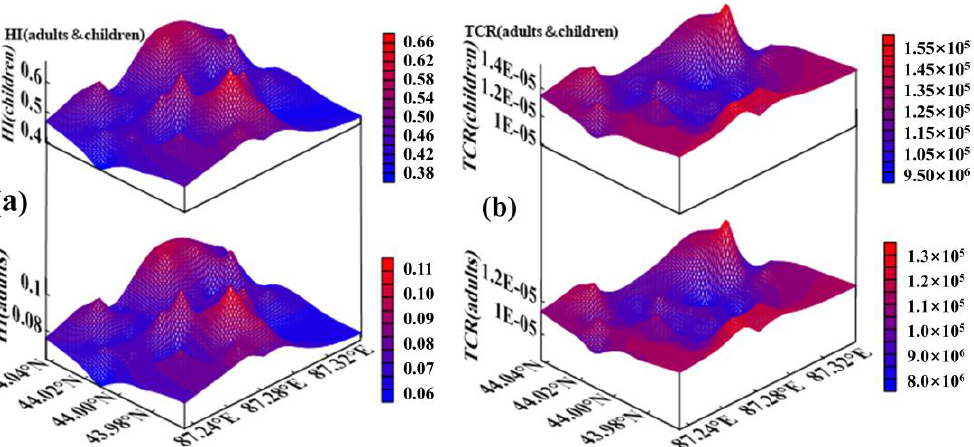
Figure 5. Spatial distributions of HI and TCR for children and adults. (a) represents the hazard index (HI) for children and adults; (b) represents total cancer risk (TCR) for children and adults.